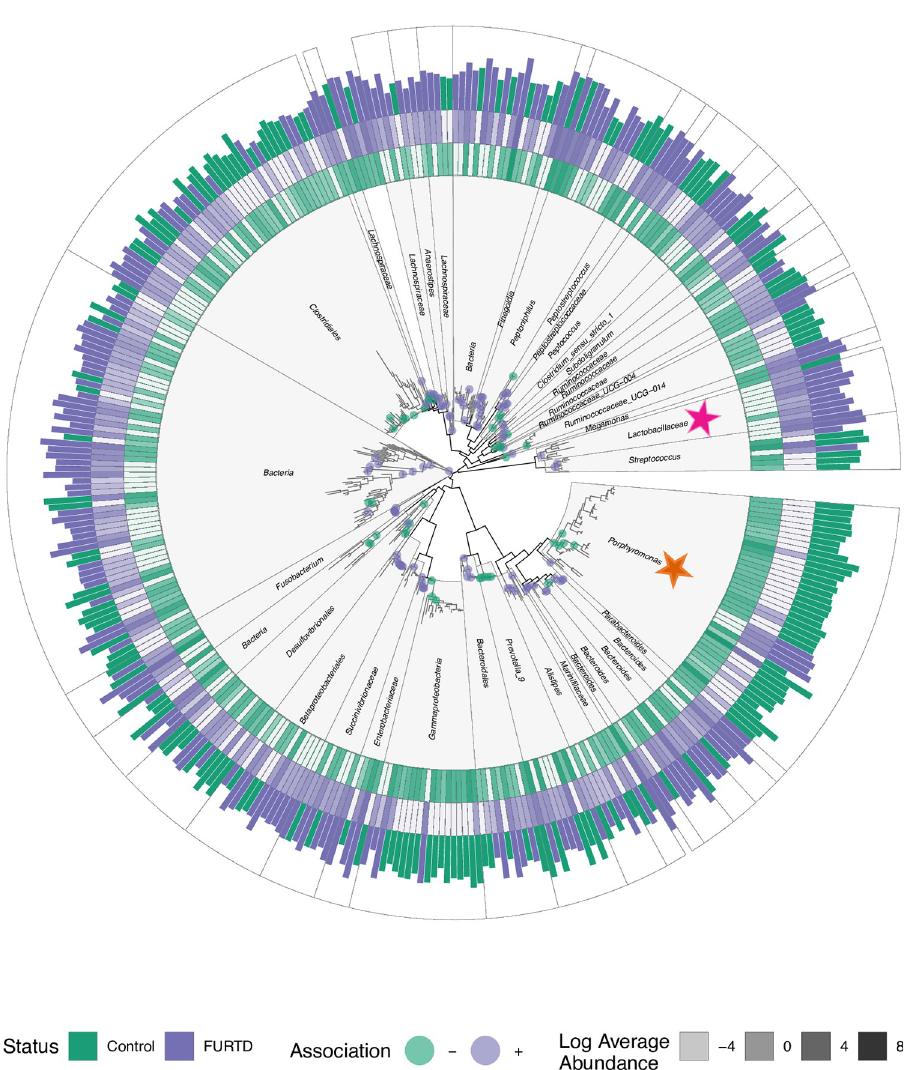
Fig 4. Monophyletic lineages within the gut microbiome reveal distinct cladal patterns of association with clinical signs. CTUs and ASVs significantly associating with clinical signs were subset and displayed. Clade taxonomic labels were assigned by determining the most specific Linnaean taxonomic label that was shared by all cladal descendants. Significant associations with FURTD or control individuals indicated with purple and green points respectively. Tiles represent the log transformed average abundances of each ASV in individuals without ( green tiles , inner ring ) and with ( purple tiles , middle ring ) clinical signs. Bar colors along the outside ring of the figure represent the average abundance of the status group with the higher value for that particular ASV. For example, a bar is colored green if cats within the control group had a higher average abundance for that particular ASV compared to FURTD cats. In this example, the bar size would correspond to the average ASV abundance for cats within the control group. Orange and pink stars are referred to as points of interest in the